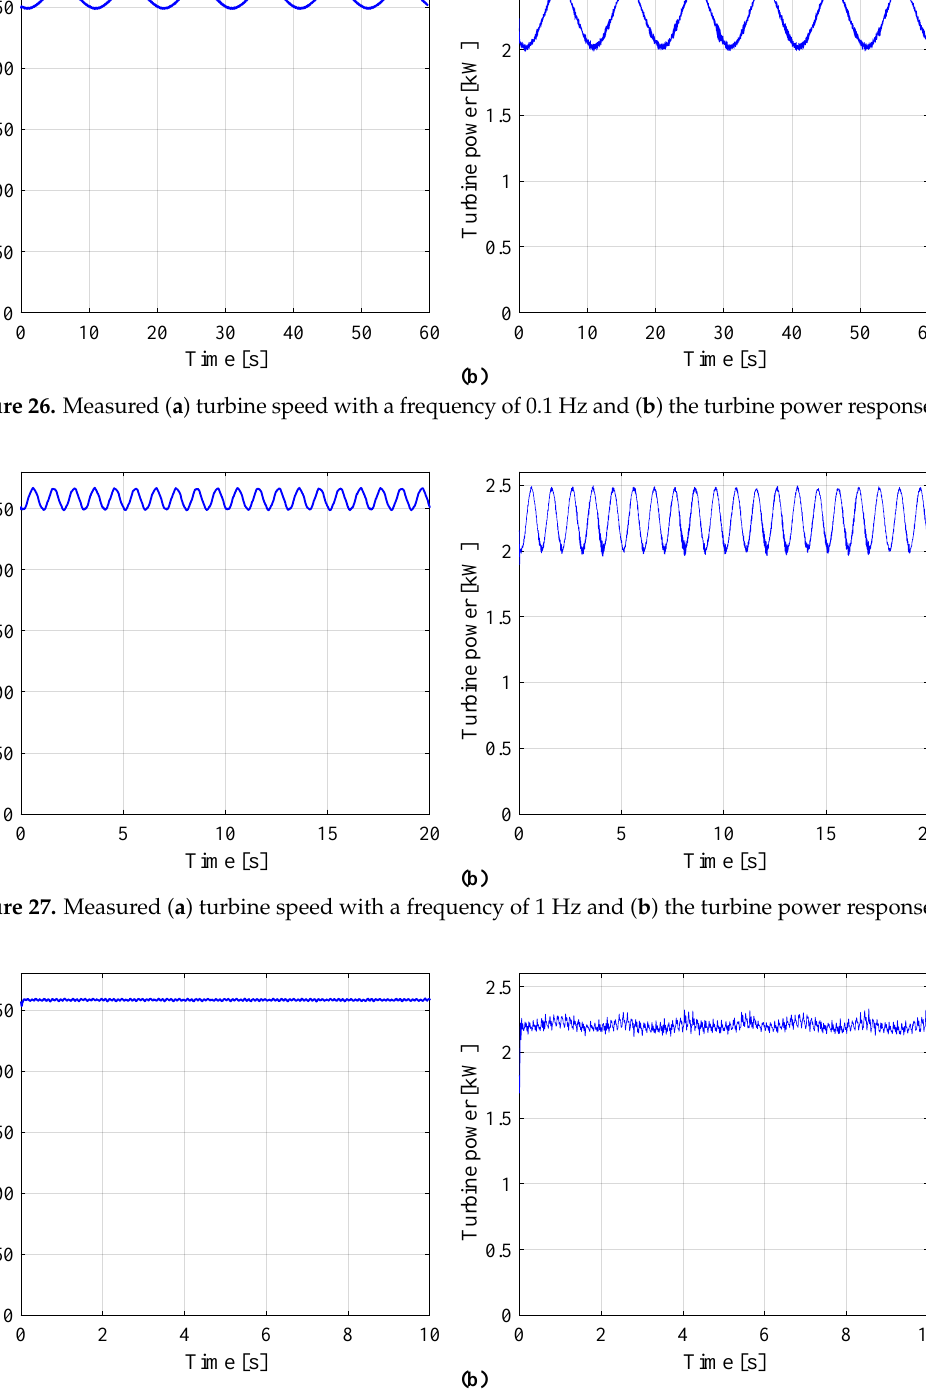
Figure 28. Measured ( a ) turbine speed with a frequency of 10 Hz and ( b ) the turbine power